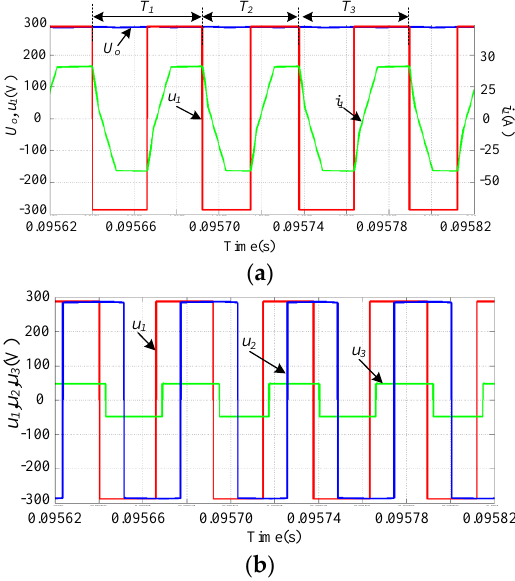
Figure 17. Simulated waveforms of shifted-phase angle control with discretely chaotic modulation: ( a ) converter voltage, current of port 1 and output voltage of port 2; ( b ) converter voltages of port 1, 2 and 3.